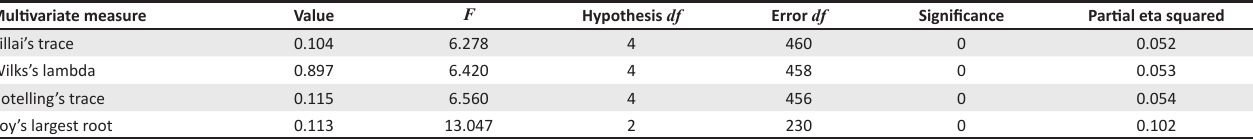
TABLE 4: Multivariate analysis. Multivariate measure